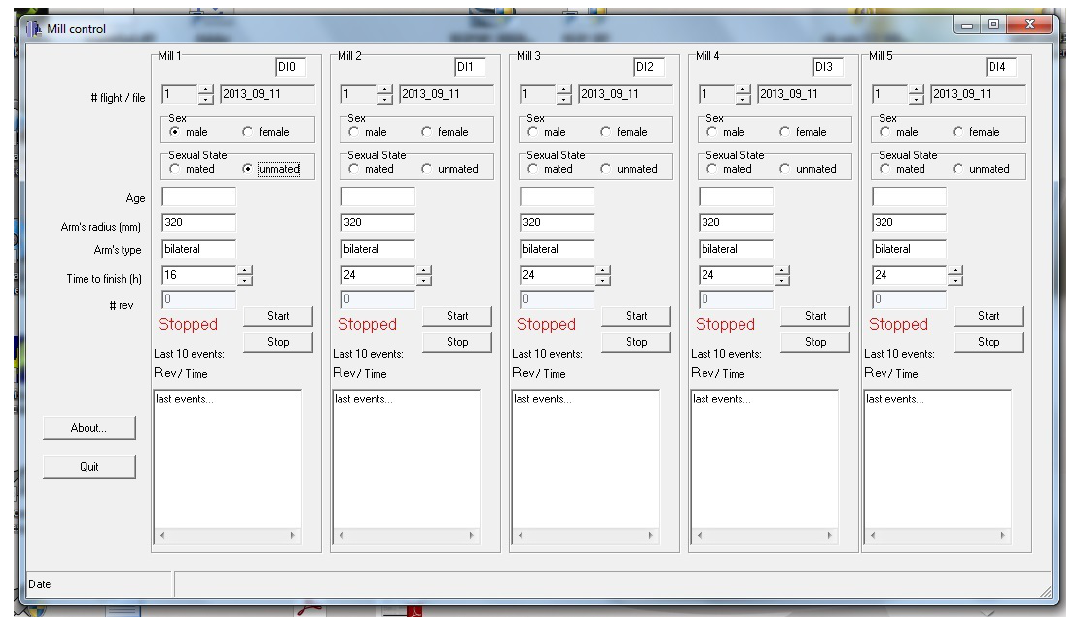
Figure 13. Interface of the application for capturing events (arm